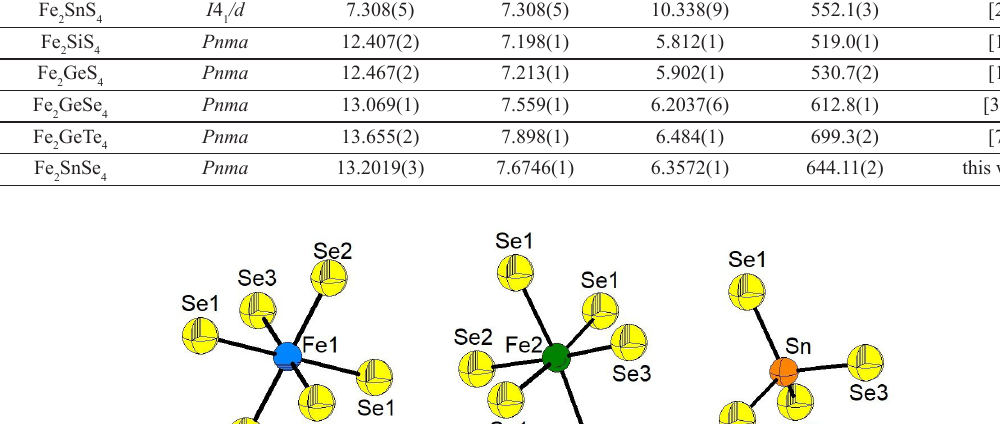
-IV-VI (IV= Si, Ge, Sn; VI= S, Se, Te). 2 4